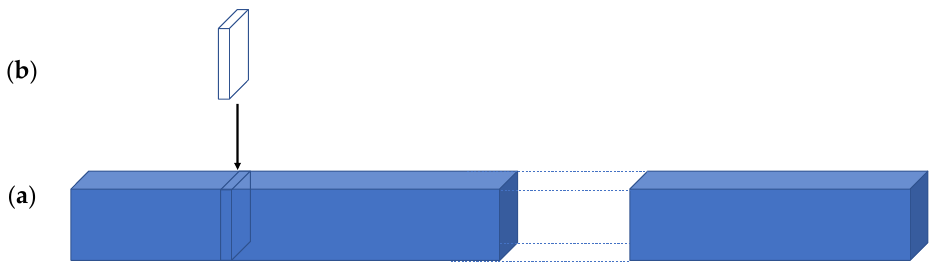
Figure 1. A depiction of the space of all possible discernably different images. ( a ) Suppose that part a is a depiction of a stack of upright images and assume that, for the scale in the figure, the stack represents a billion images. ( b ) The stack in a is taken from the space of all possible different images represented by the extended rectangular cuboid whose length is unknown.